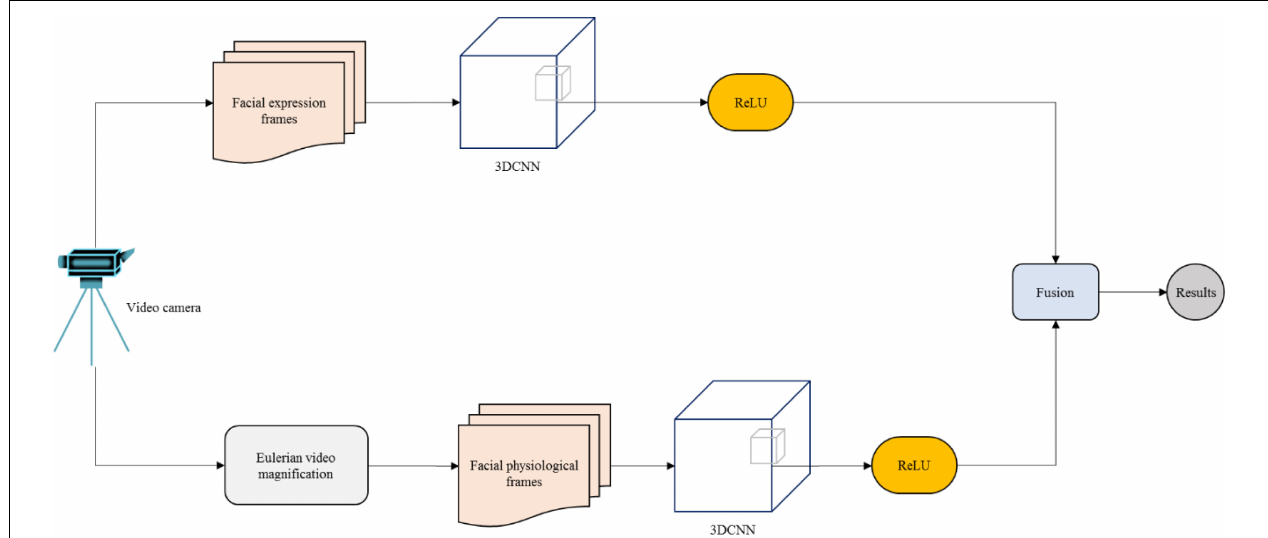
FIGURE 1 | Dual-modality emotion recognition